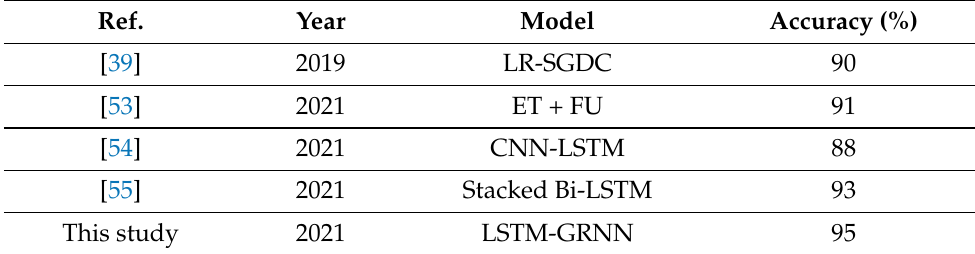
Table 18. Performance comparison with previous